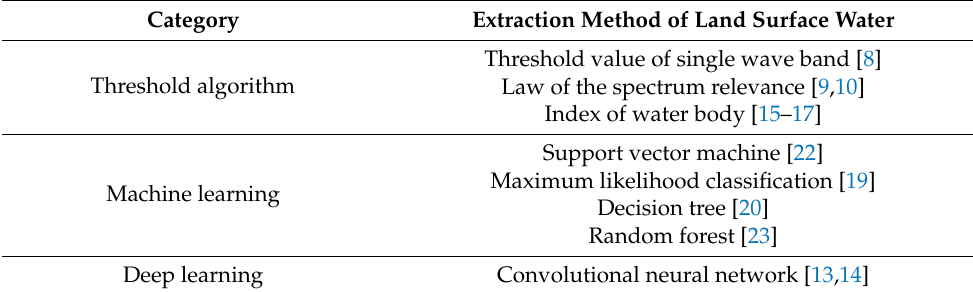
Table 1. Recent methods for land surface water